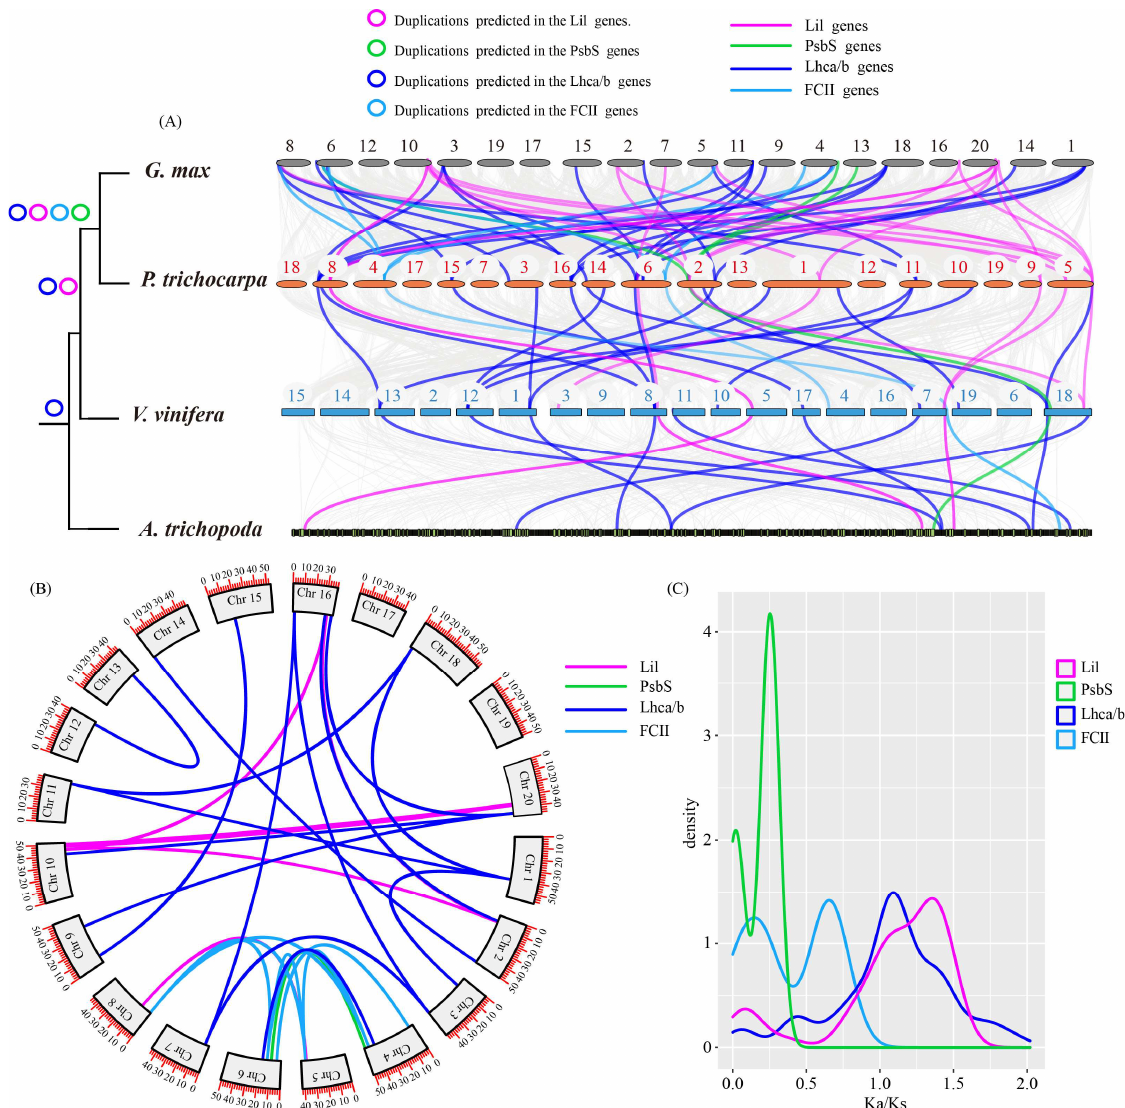
Figure 8. Duplication events of LHC genes in G. max . ( A ) Syntenic relationships of LHC genes among Glycine max , Populus trichocarpa , Vitis vinifera , and Amborella trichopoda ; ( B ) syntenic relationships of LHC genes in Glycine max/ Glycine max ; ( C ) distribution of Ka/Ks values among LHC genes in Glycine max .